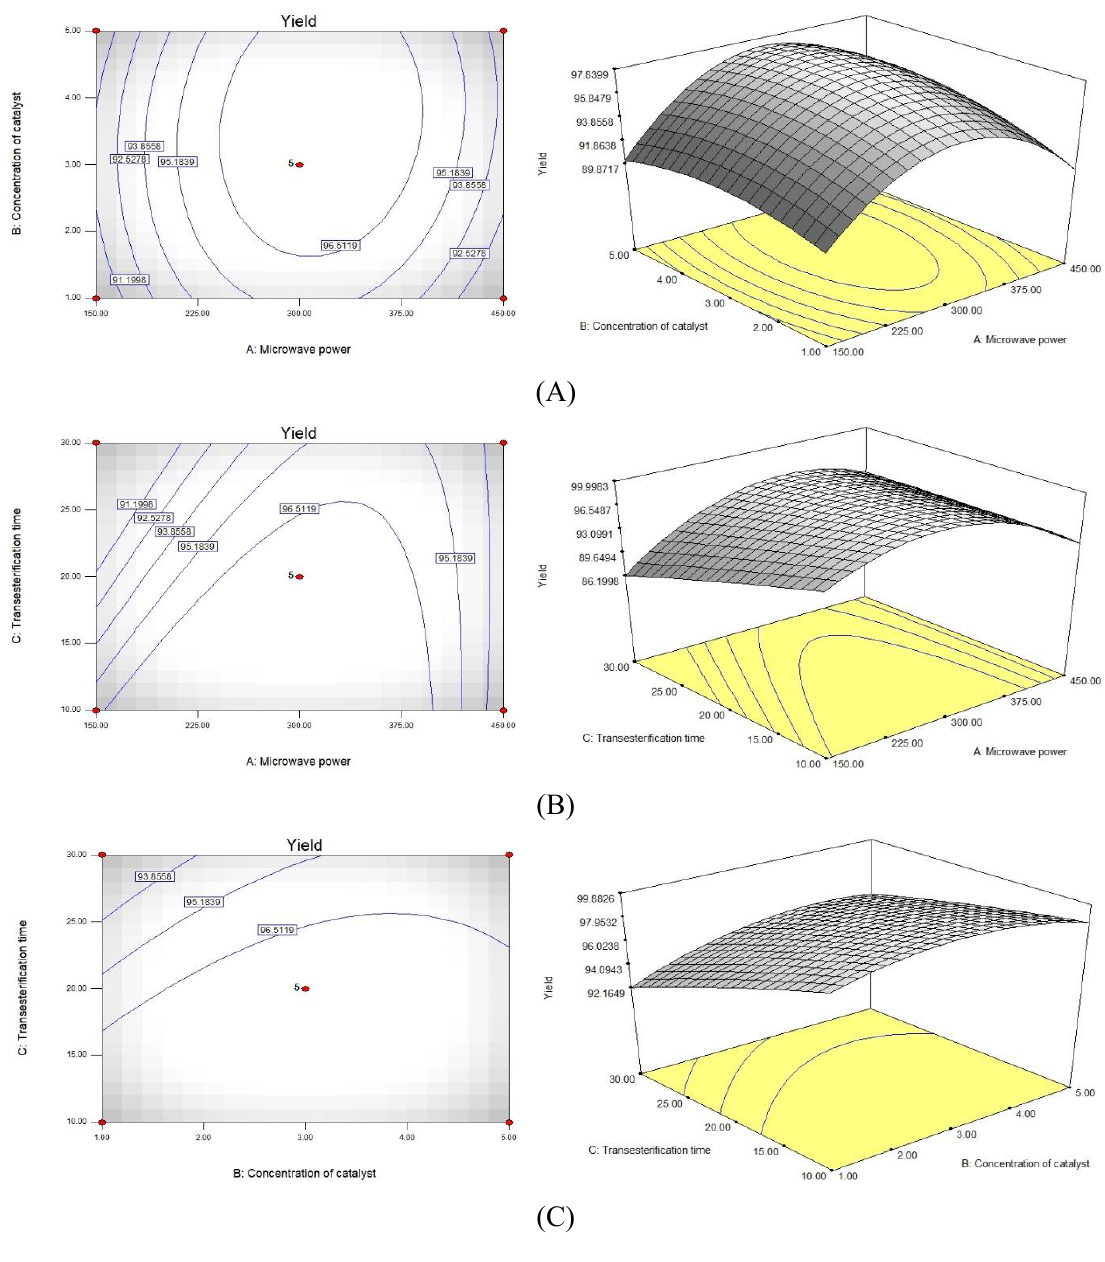
Figure 6: 2-D and 3-D response surface plot showing interactions of: (A) microwave power and concentration of catalyst with fixed transesterification time of 20 min, (B) microwave power and transesterification time with fixed concentration of catalyst of 3%, and (C) concentration of catalyst and transesterification time with fixed microwave power of 300